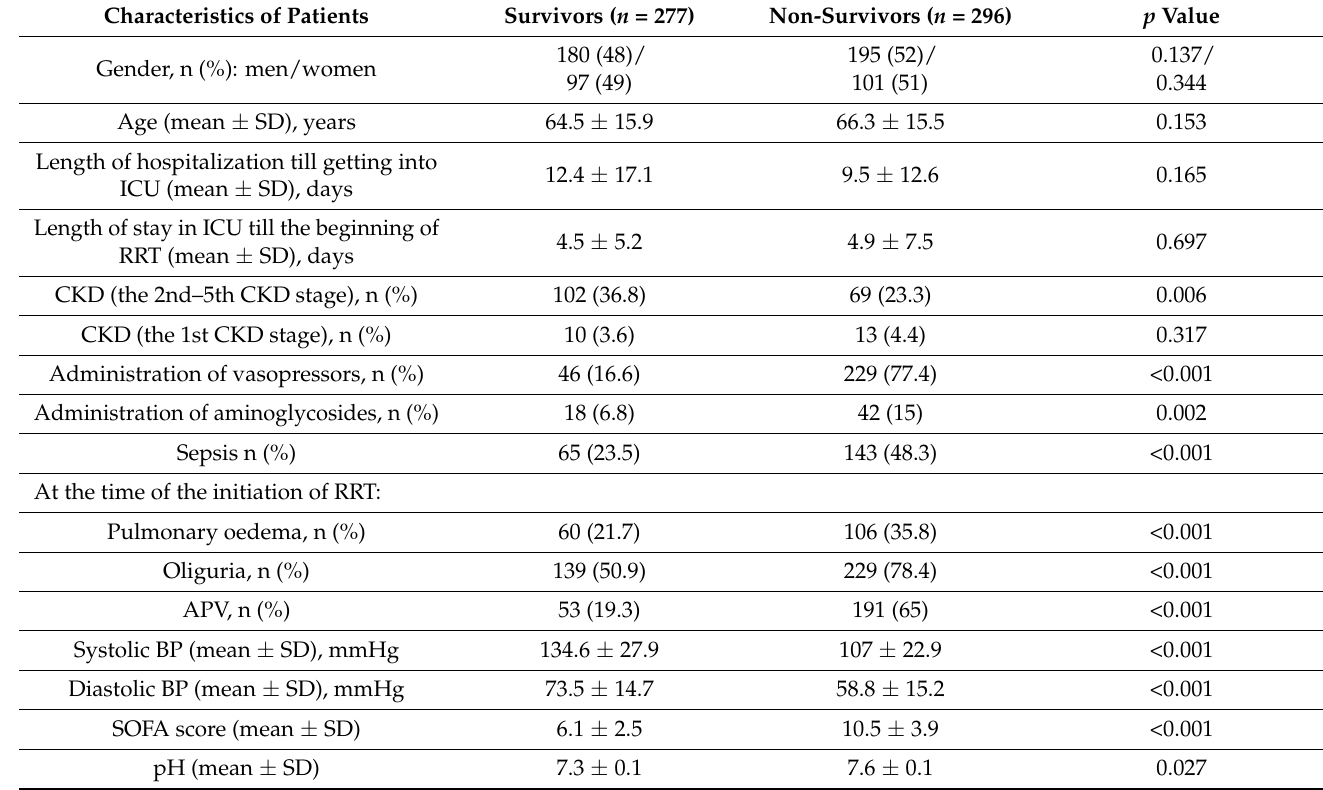
Table 2. The demographic and clinical data of the survivors and non-survivors with severe acute kidney injury. Characteristics of Patients Survivors ( n = 277) Non-Survivors ( n = 296) p